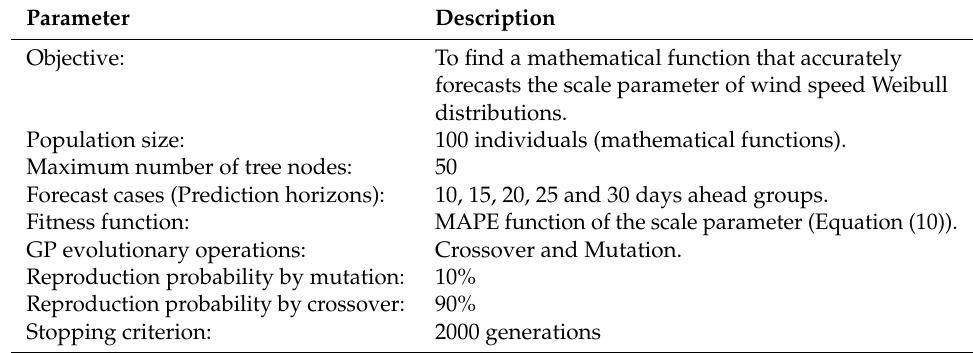
Table 5. Specifications of the GP process to forecast the scale parameter of wind speed Weibull